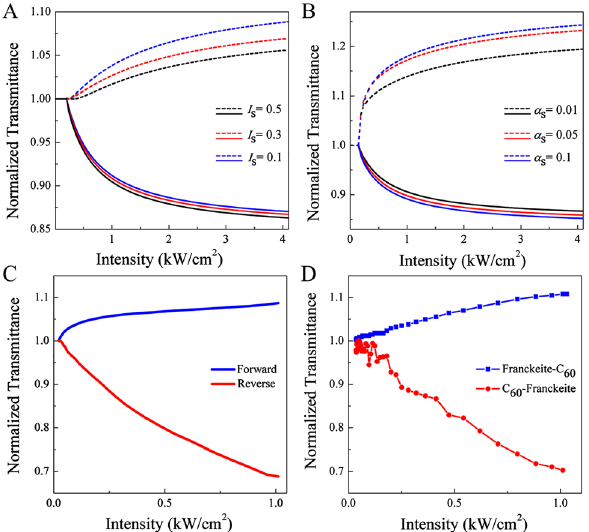
Figure 5: Nonreciprocal transmission characteristics of the passive photonic diode based on nonlinear optics.